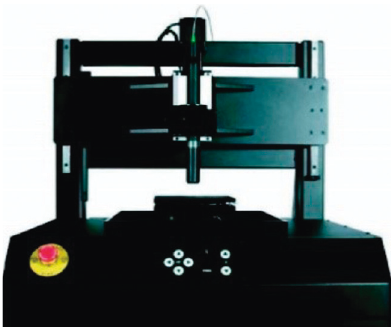
Figure 5: ST500 ultrafast large area profilometer.